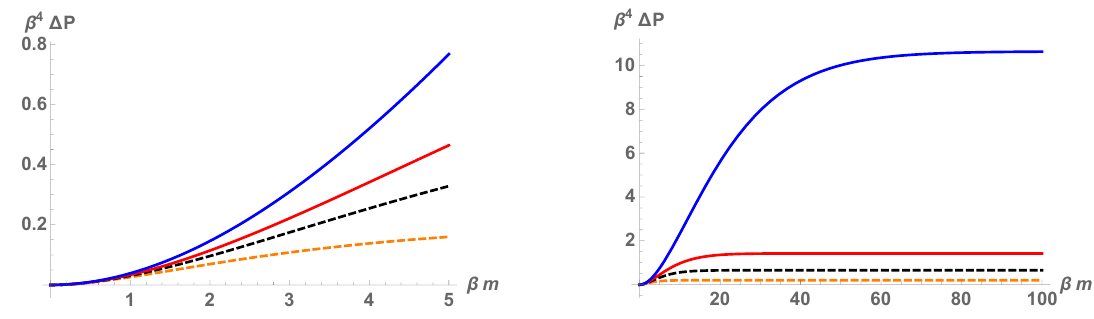
Figure 7 . The force on the bubble ∆ P z defined in (3.39) as a function of m/T for γ = 1 . 1 (orange dashed), γ = 1 . 5 (black dashed), γ = 2 (solid red), and γ = 5 (solid